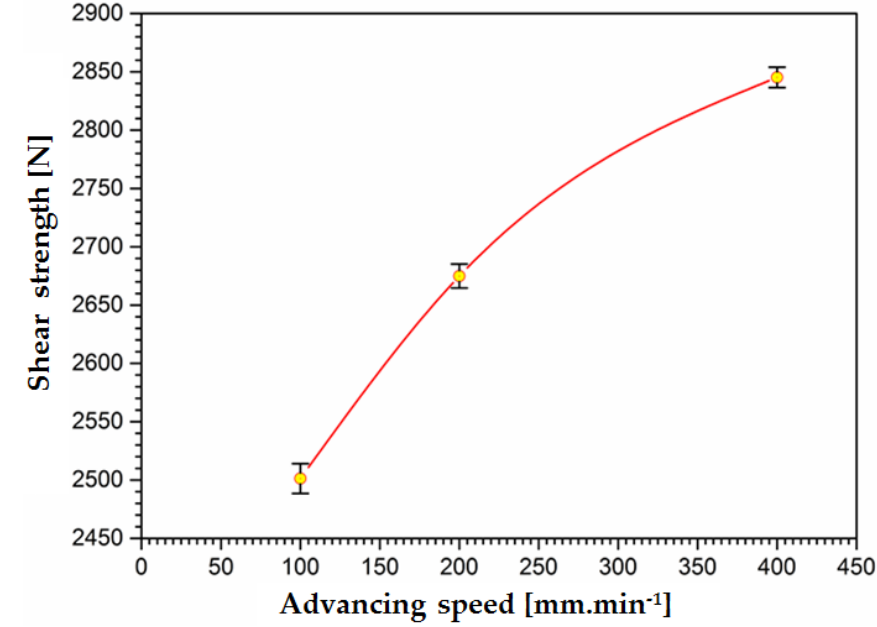
Figure 12. Curve of shear strength vs. advancing speed using welding conditions: rotational speed of 1200 rpm; tool offset of −0.1 mm of friction stir welded 6061-T6 aluminum alloy to ultra low carbon steel.